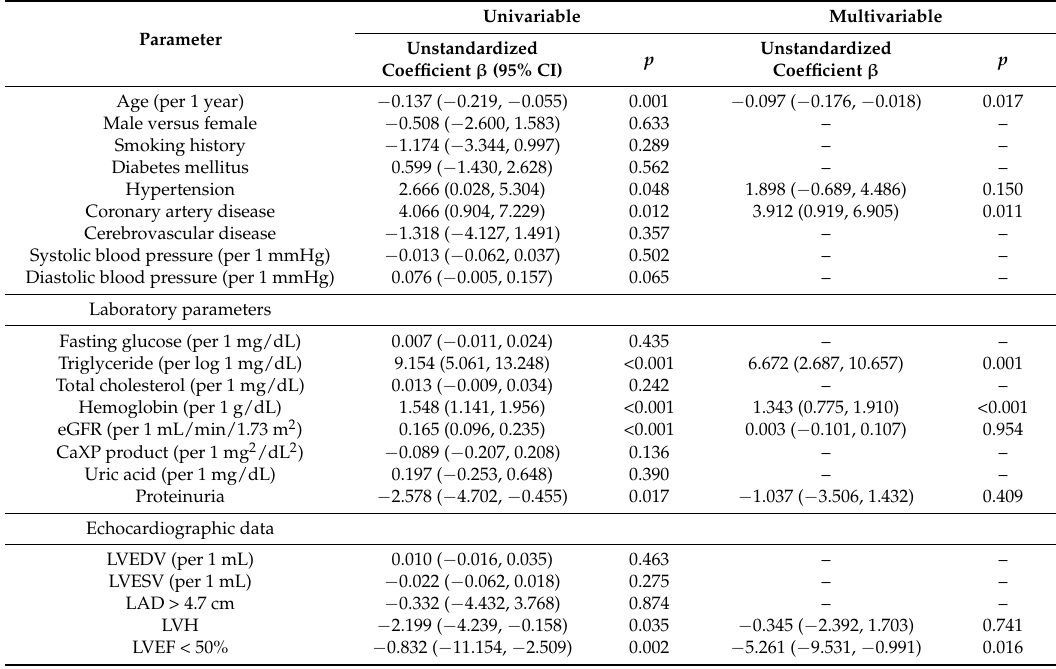
Table 3. Determinants of GNRI in study